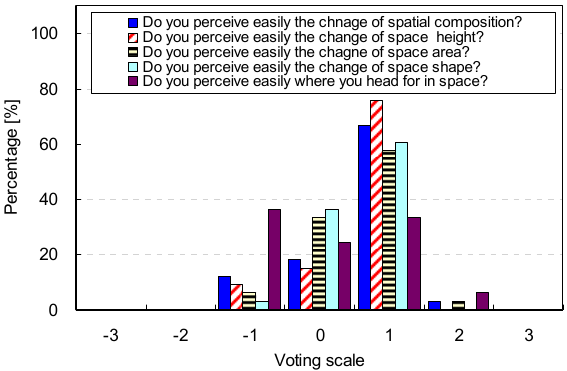
Figure 4. Participants’ ability to perceive change in the spatial components.